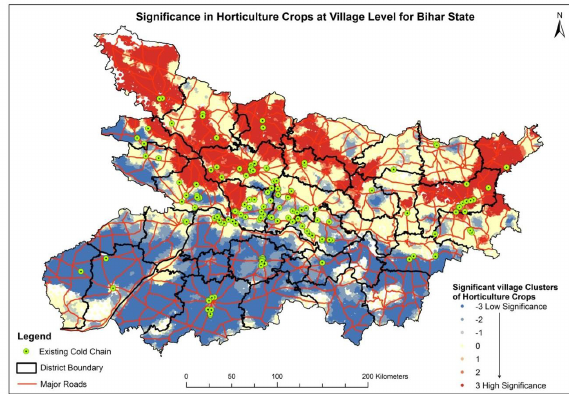
Figure 10. Significance map of horticulture crop, prepared based on the horticulture land use proportion map